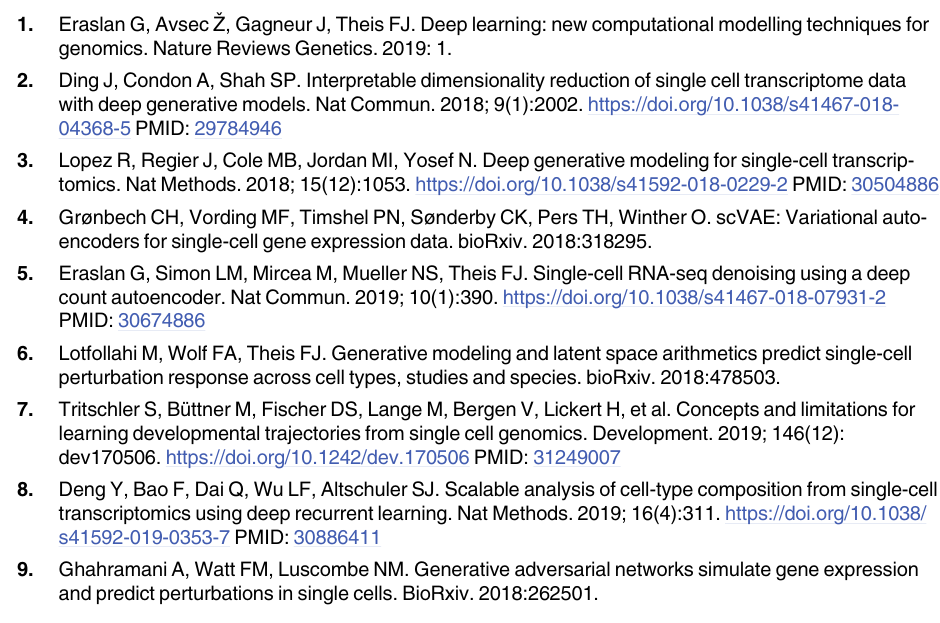
augmented real samples (blue) and the 846 generated samples (red) corresponding Fig 2A. Correlation coefficient distributions for all pairs within the 846 real data (blue) and for pairs between the 846 real and 846 fake data (red) at the 100k epoch corresponding Fig 2B. tSNE plots at four epochs with different colored dots representing the 762 training (red) samples, 84 test (blue) samples and 84 generated samples (orange) corresponding Fig 2C. Transition curves of selected four genes from 7M WT to 7M AD corresponding Fig 3A and 3B. S1 Table. DEGs for 2M, 4M and 7M. Three sheets by month include scaled counts per pheno- type, log2FC, p-value and adjusted p-value, which are evaluated by DESeq2 package. S2 Table. WikiPathway, KEGG, and GOBP results by WebGestalt. Eight sheets by patterns (Up, Down, P1, P2, P3, P4, P5, P6) include significant pathways (FDR < 0.05) with enrichment ratio, p-value, FDR and genes. Two additional sheets show 50 selected pathways to compare results by